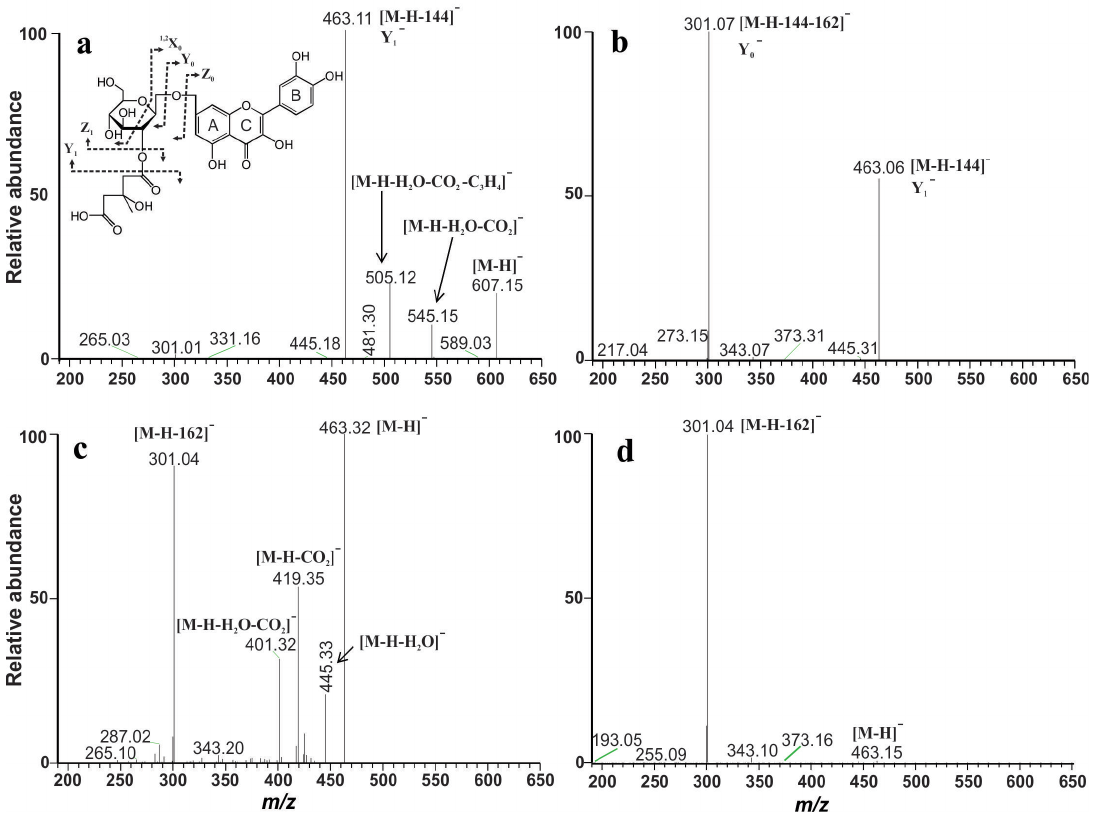
Fig. 3: ESI-MS/MS spectra of quercetin derivatives. (a) MS 2 of [M − H] − at m/z 607 and (b) MS 3 (607 → 463) of compound 1C . MS 2 of [M − H] − at m/z 463 of compounds 4K (c) and 10S